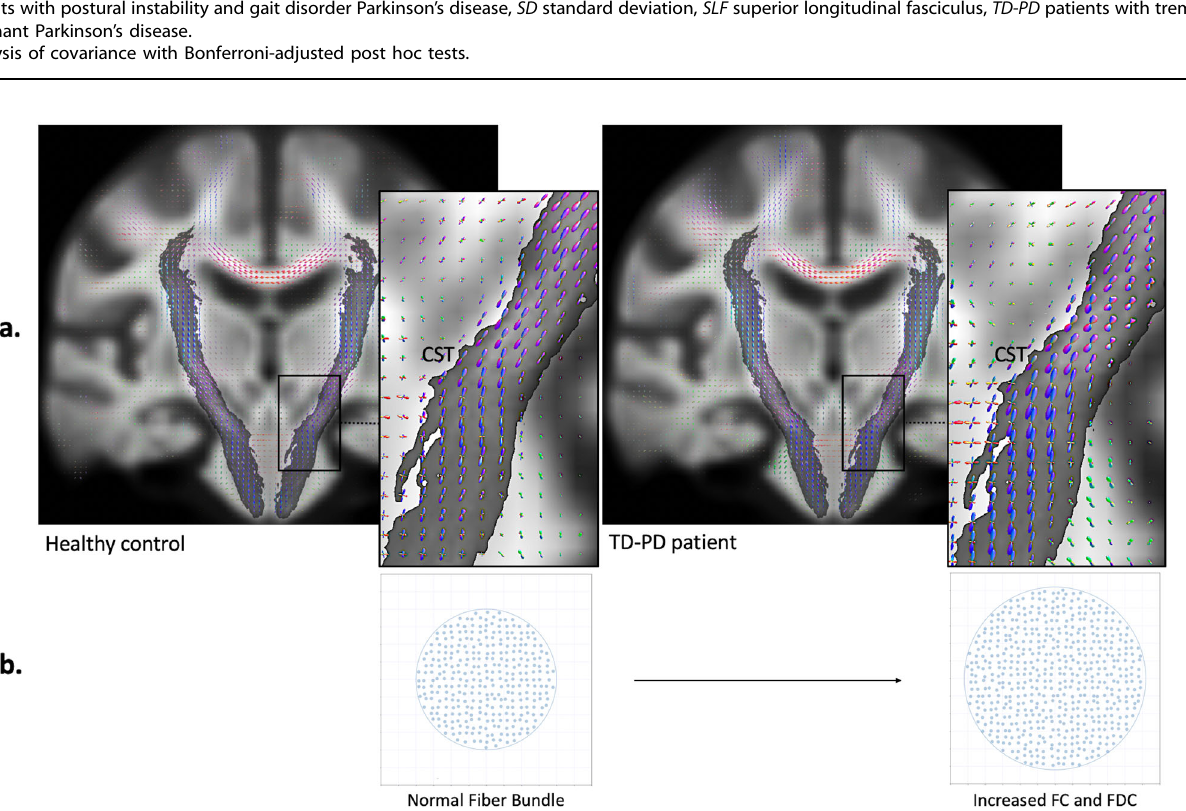
Fig. 3 The interpretation of fi xel-based metrics changes. a Representative images show the enlargement of fi ber orientation distributions ’ amplitude, which re fl ects an increase in intra-axonal volume 12 , in the corticospinal tract (CST) in a patient with tremor-dominant Parkinson ’ s disease (TD-PD) compared with healthy control. b The schematic represents a fi ber-bundle cross section (blue circles represent axons, and the grid represents imaging voxels). The increase in intra-axonal volume might indicate a fi ber-bundle enlargement due to increases in axon number, as indexed by greater fi ber cross section (FC) and a combined measure of fi ber density and cross section